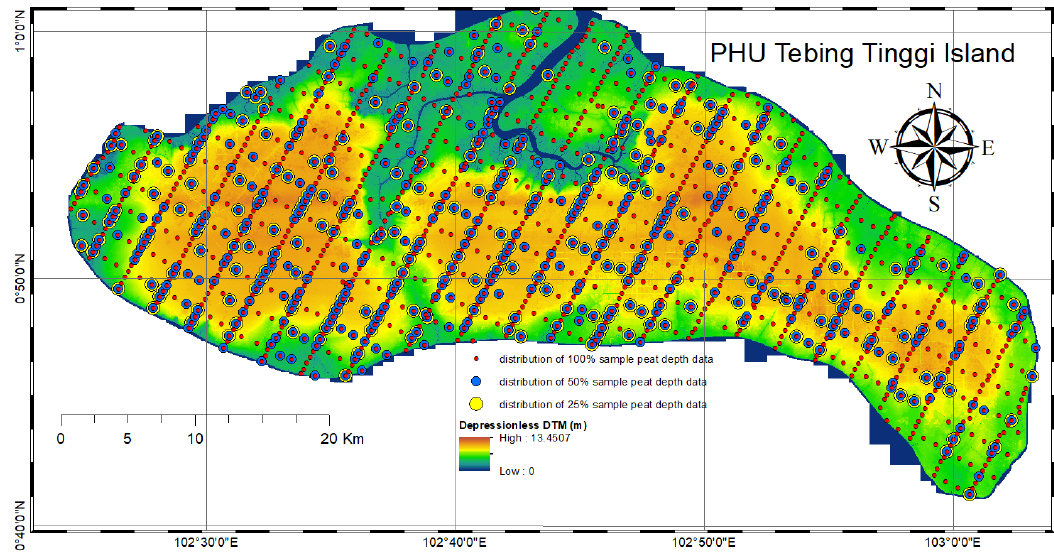
Figure 3. Condition of topographic (depressionless digital terrain model (DTM) above the local MSL) and distribution of peat measurements on file.